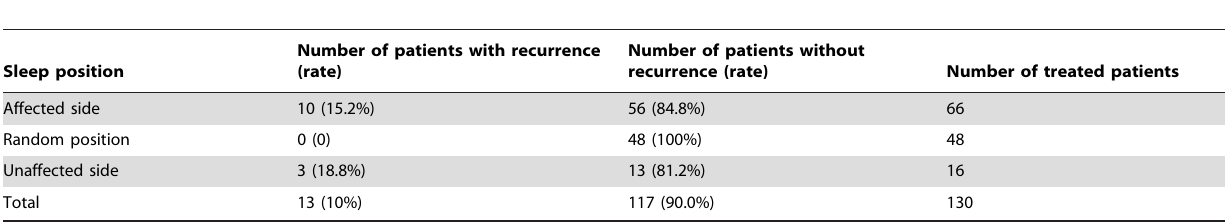
Table 3. The comparison of recurrence rates in patients who slept in different positions during the 2–4 weeks after the repositioning maneuver (excluding the recurrent patients in one week after repositioning maneuver).